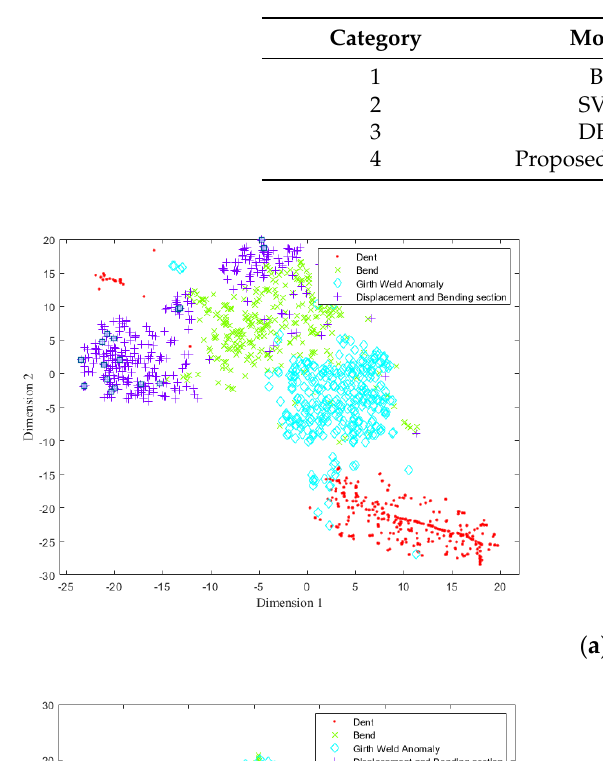
Table 2. Accuracy comparison of the different methods.